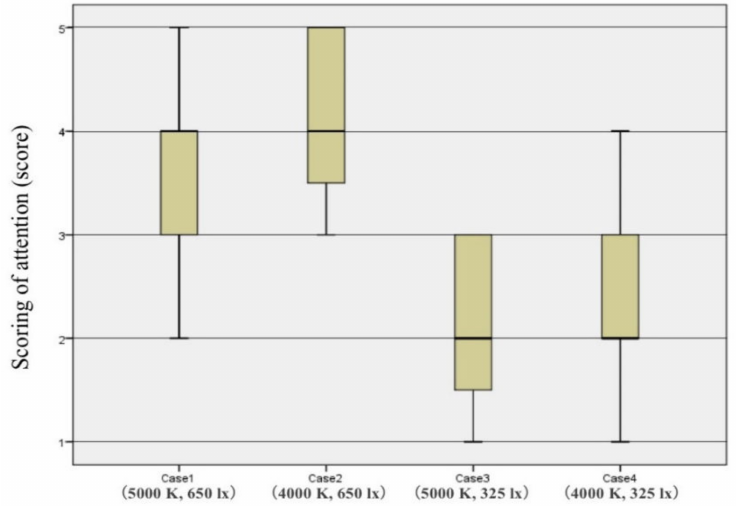
Figure 8. Comparison of subjective evaluation on “concentration” in different illumination